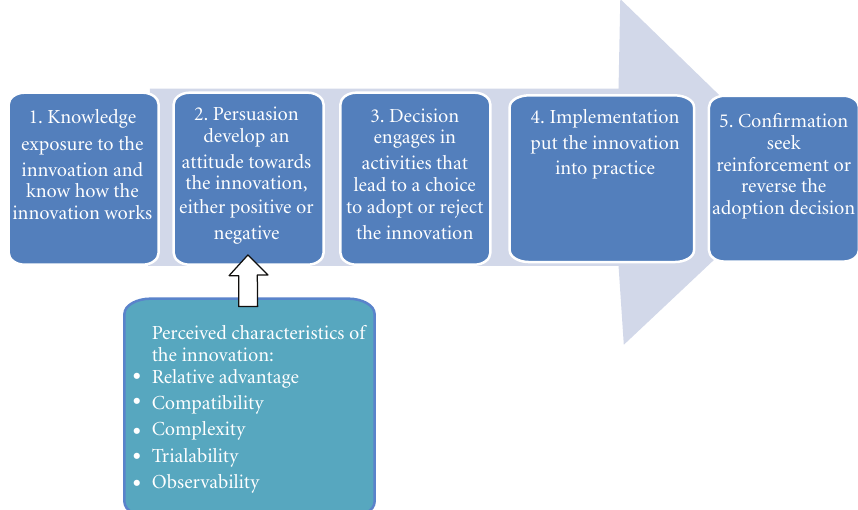
Figure 1: Five stages in the innovation-decision